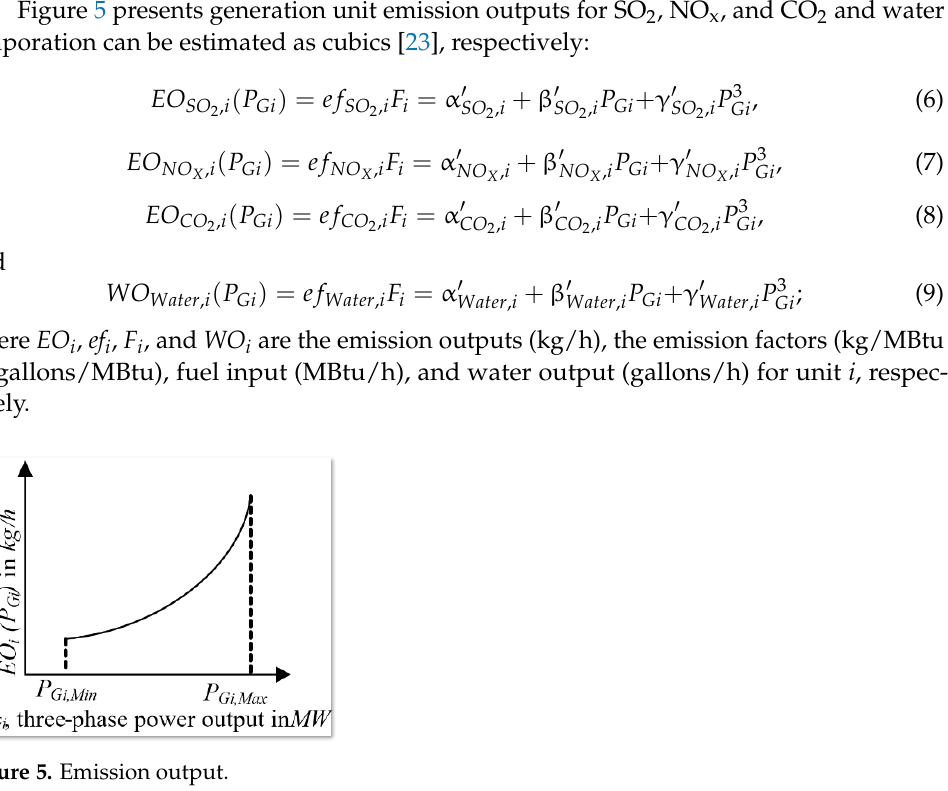
Figure 5. Emission